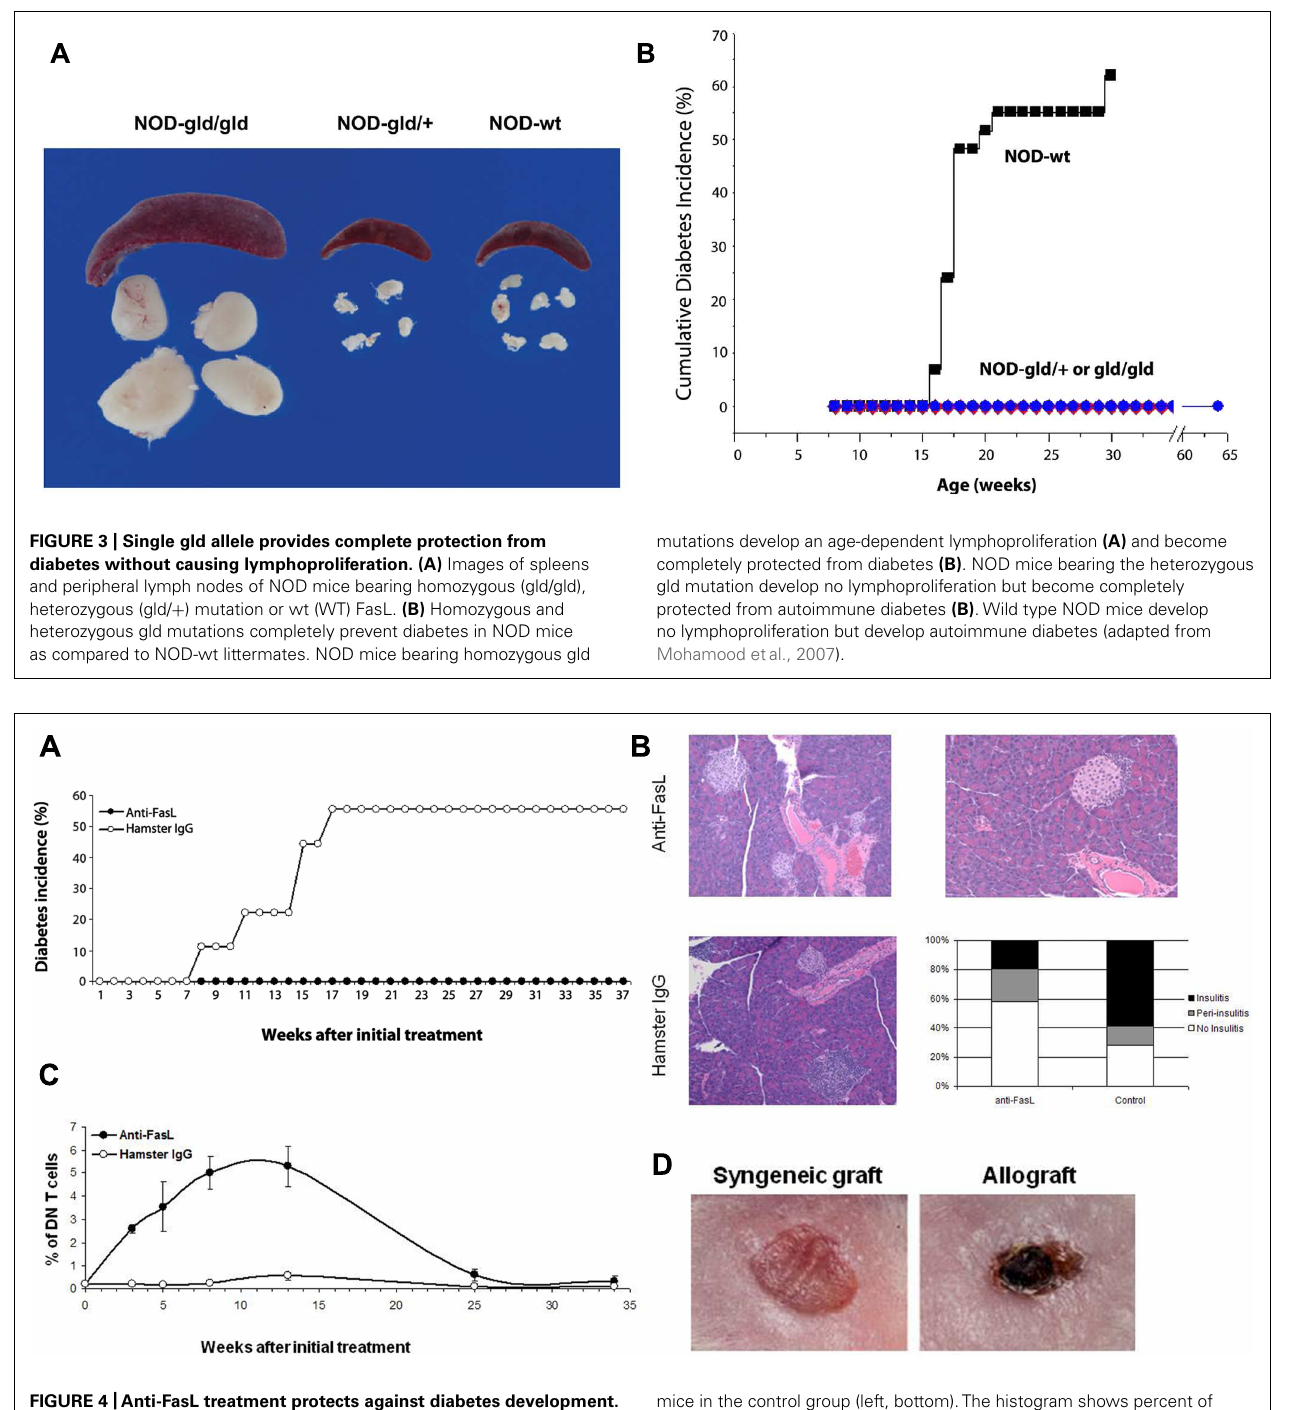
FIGURE 4 |Anti-FasL treatment protects against diabetes development. Four-week-old NOD-wt mice were injected weekly, i.p. with 500 μ g of anti-FasL MFL4 antibody ( n = 10) or control hamster IgG ( n = 9) for two consecutive weeks followed by 300 μ g weekly injections until the age of 16 weeks. (A) Diabetes incidence in the two groups. (B) Anti-FasL treatment curtails insulitis development in NOD-wt mice. Pancreata from three mice in the anti-FasL group or from three non-diabetic mice in the control group were collected 9 weeks after termination of the treatment and analyzed for insulitis. Representative H&E sections show no insulitis (top, left) or peri-insulitis (top, right) in islets of mice that received anti-FasL and severe insulitis in islets of